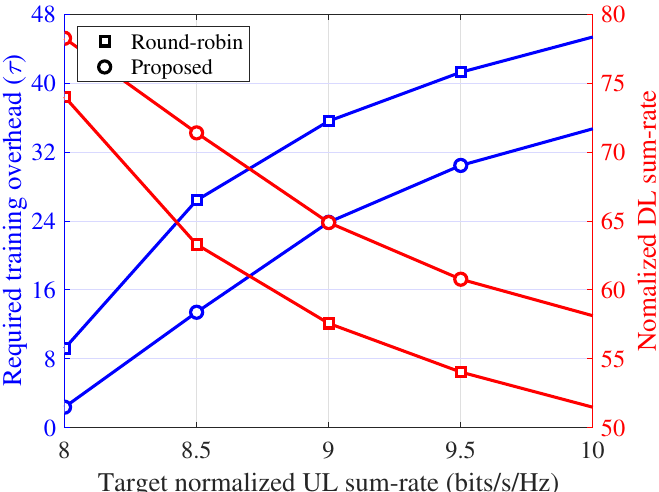
Figure 10. Required training overhead ( τ ) and normalized DL sum-rate ( η d ) per channel use according to the target normalized UL sum-rate: K u = 8, κ ij = 3, and 80 dB path loss between the BS and